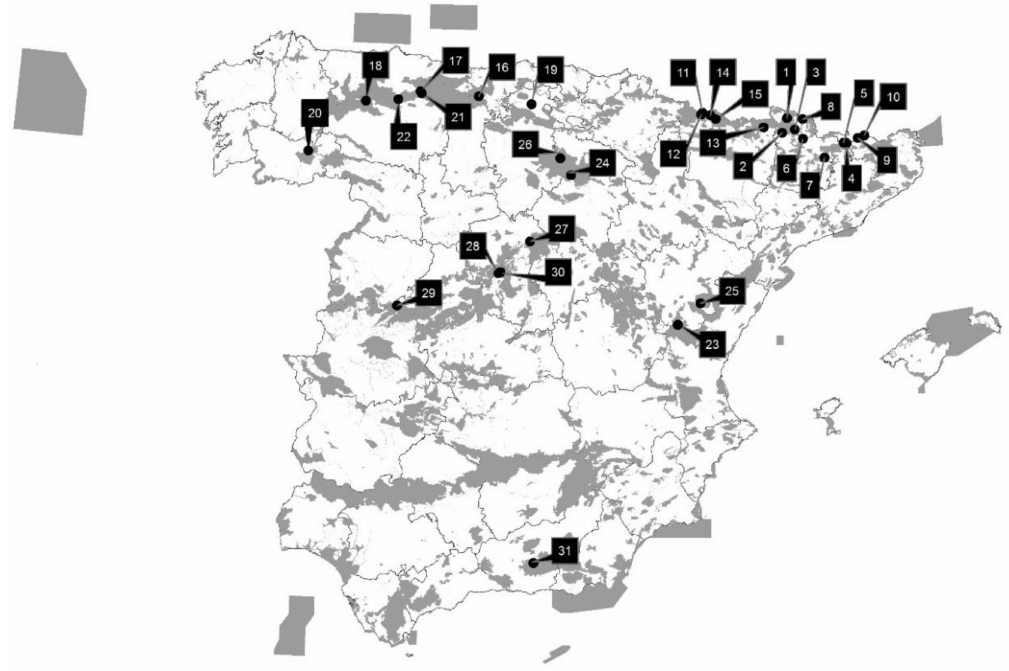
Figure A3. Map of alpine ski resorts and LIC sites in Spain. Source: Based on http: //www.magrama.gob.es/es/biodiversidad/servicios/banco-datos-naturaleza/informacion-disponible/ rednatura_2000_zepa_descargas.aspx (accessed in December 2015). Legend: Same information as Figure